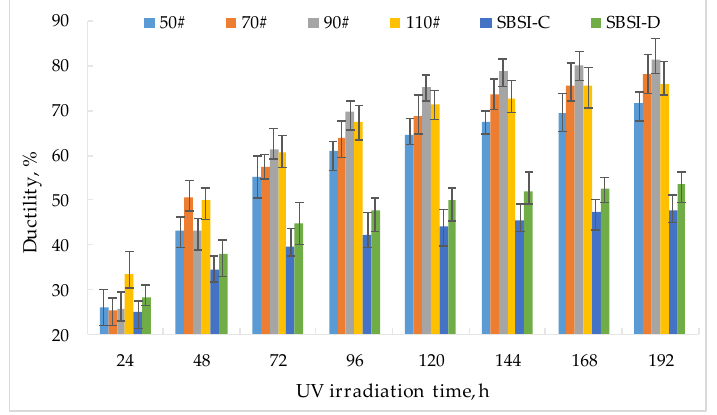
Figure 9. The ductility loss rate of asphalt with different UV irradiation time (the test temperature of base asphalt is 10 °C while that of SBS modified asphalt is 5 °C).